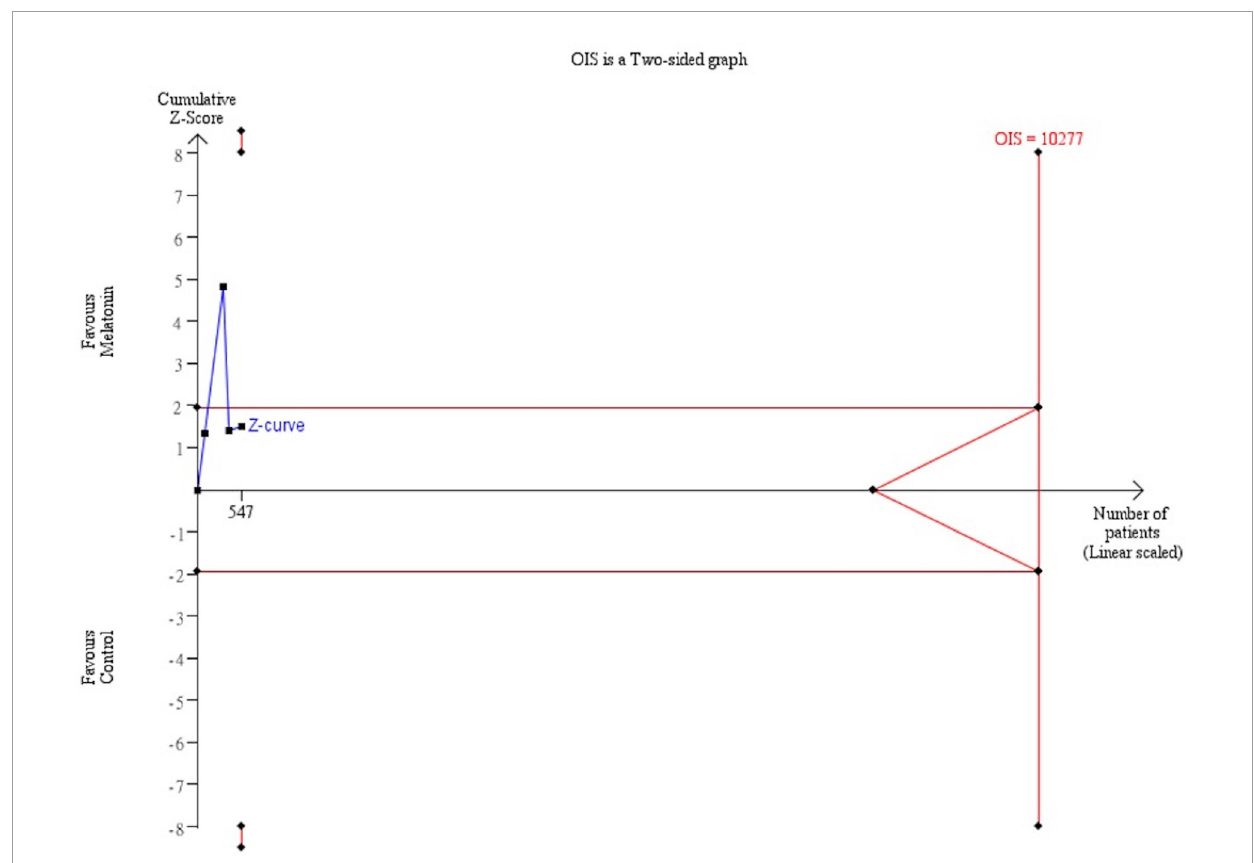
FIGURE5 Trial sequential analysis of mortality rate. A diversity adjusted information size of 10,277 patients was calculated using 5% of type 1 error (2-sided), a power of 80%, an anticipated relative risk of